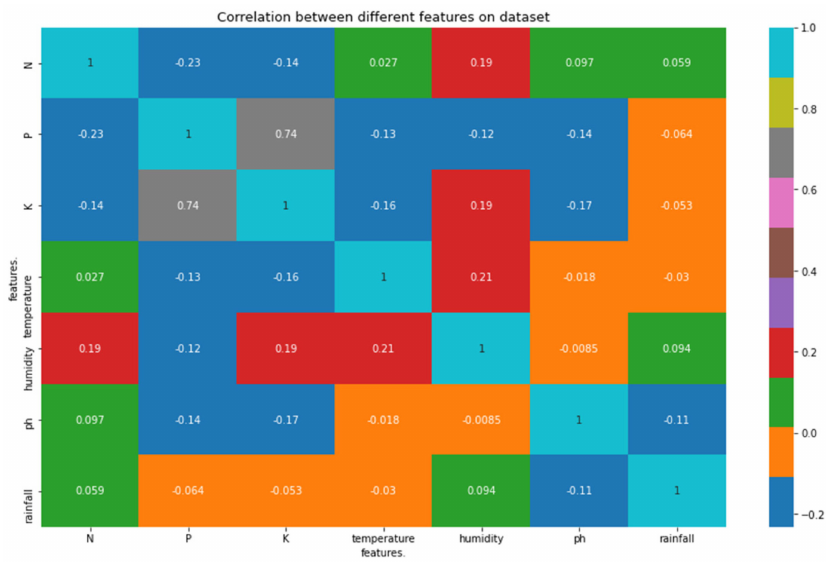
Figure 7. Correlation matrix showcasing correlation between different features of the